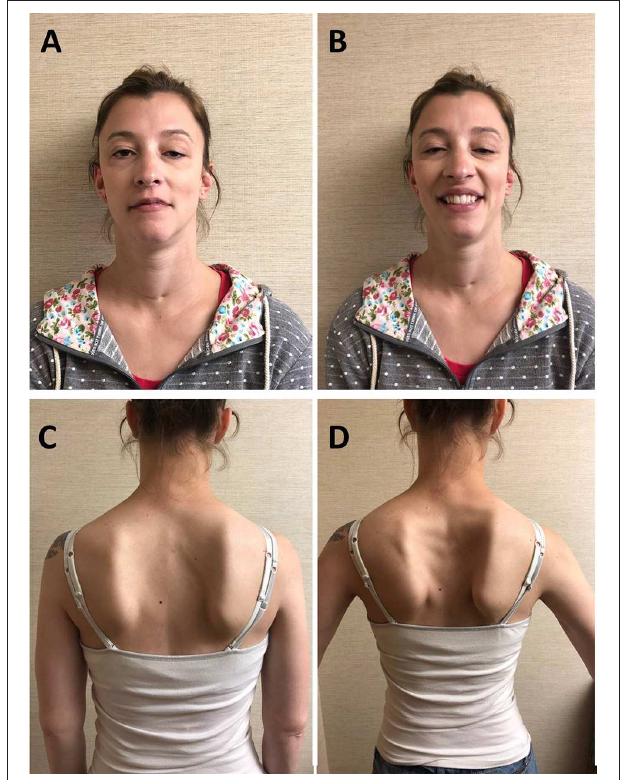
FIGURE 1 | Patient. (A) Bilateral asymmetric ptosis. (B) Limited smile due to facial weakness, micrognathia, and long neck; scar at base of neck due to tracheostomy in infancy. (C) Atrophy of the shoulder girdle and thoracic paraspinal muscles. (D) Bilateral scapular winging.